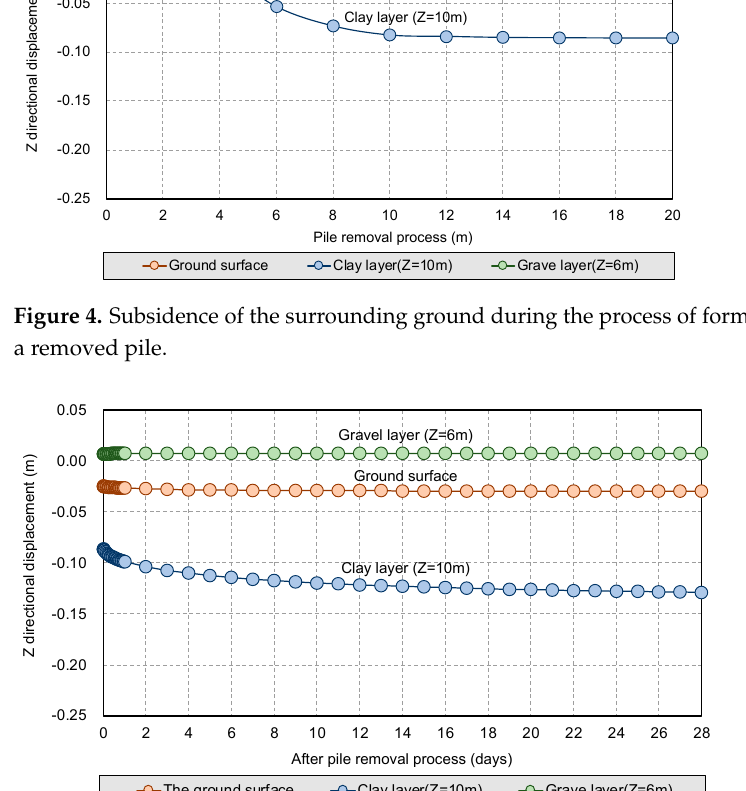
Figure 5. Subsidence of the surrounding ground after forming one extraction hole of a removed pile.